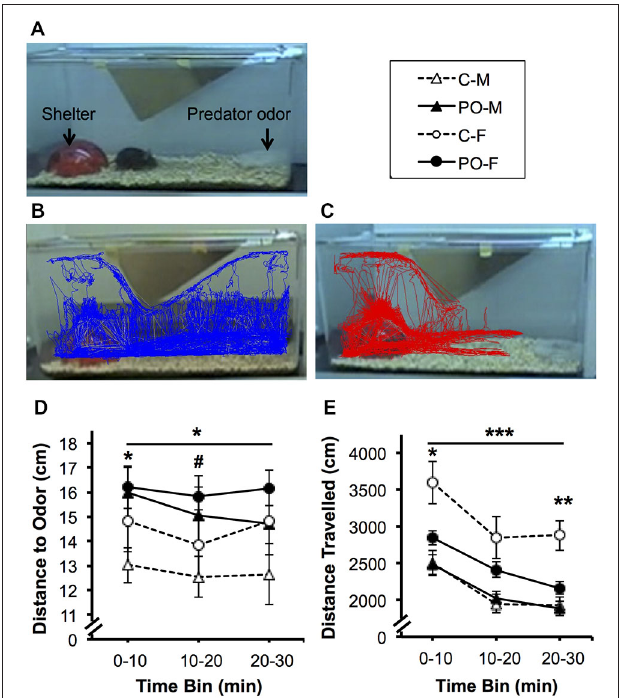
FIGURE 3 | Adult offspring from dams exposed to predator odor during pregnancy (PO) show increased avoidance and decreased predator-odor associated activity compared to control (C) adult offspring . M, male; F, female. (A) Predator odor exposure setup. Representative 30-min. tracing of locomotor activity from (B) control and (C) maternal predator odor-exposed adult offspring. (D) Average distance to the predator odor and (E) overall distance travelled. Data are average ± SEM. Bars, * P ≤ 0.05, *** P ≤ 0.001, main effect of maternal predator odor exposure; # P ≤ 0.10, * P ≤ 0.05, ** P ≤ 0.01 post hoc comparison within sex.